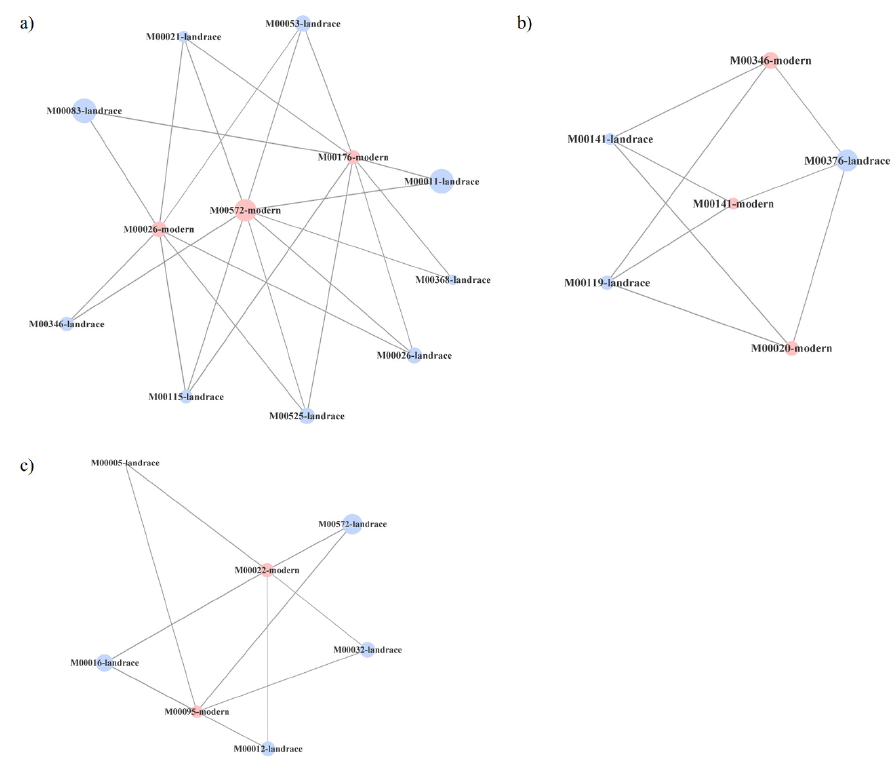
Figure 5. Three ( a – c ) most connected clusters in co-presence networks for the couple modern commercial cultivars (red):tomato landraces (blue). Node sizes reflect average relative abundance of each KEGG module. The line thickness is proportional to the edge weight.